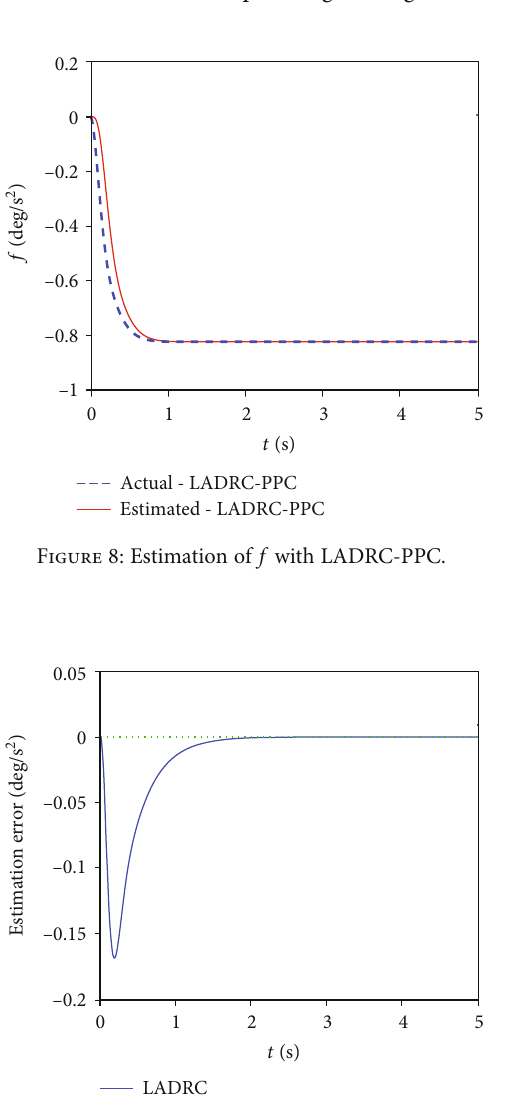
Figure 9: Estimation error of f with LADRC.